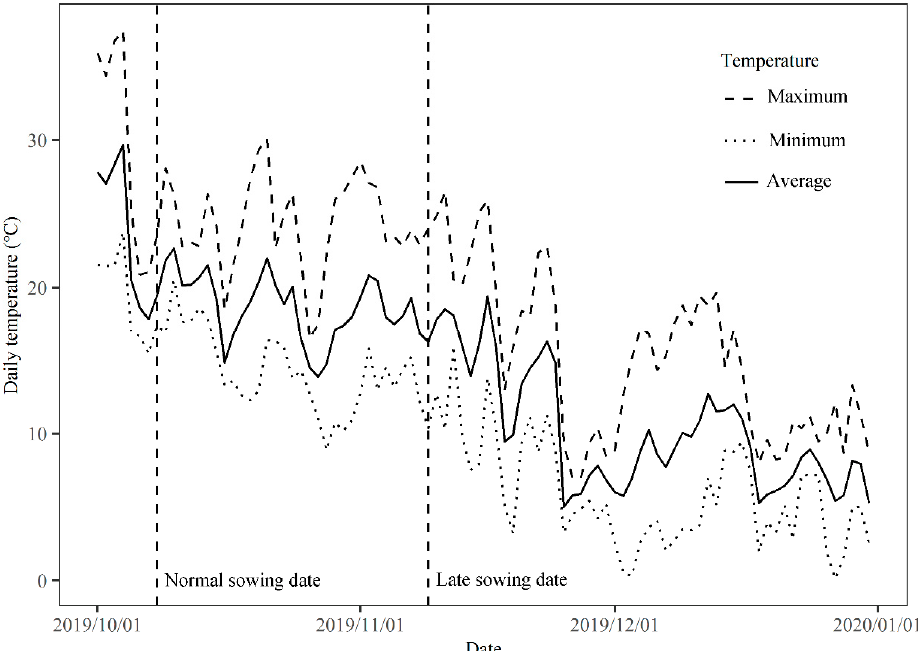
Figure 1. Dynamic changes of the average, maximum, and minimum temperatures under normal and late sowing conditions.